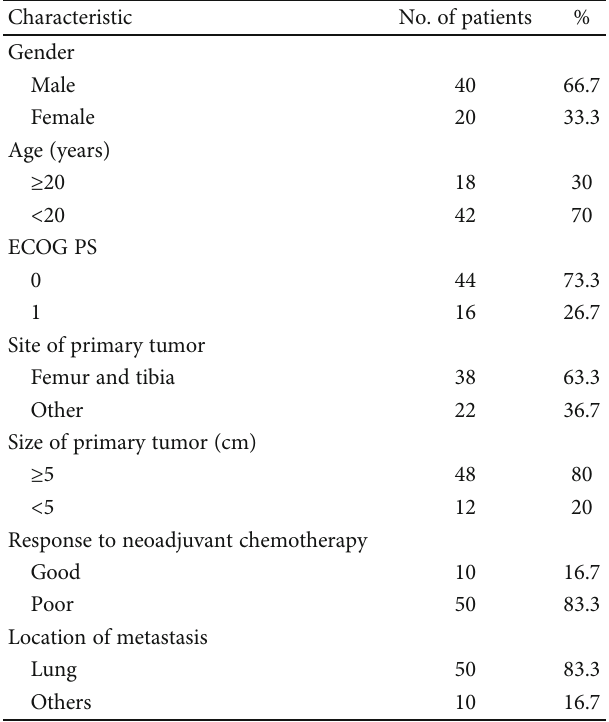
Table 1: Patient characteristics ( N = 60